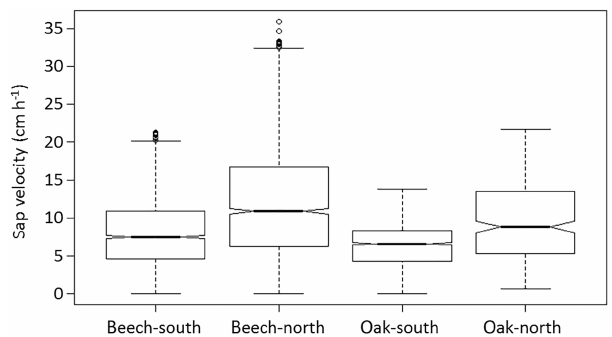
Figure A1. Sap velocities when grouped according to species and aspect.